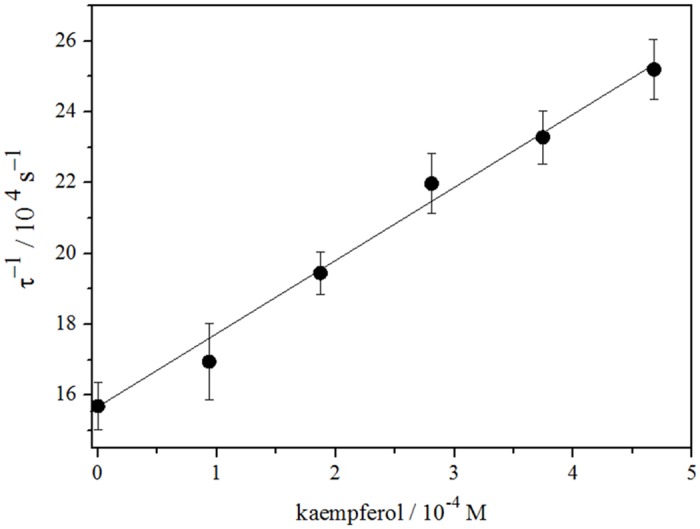
Stern—Volmer type plot for singlet oxygen deactivation by kaempferol in erythrocyte membranes at 25°C.